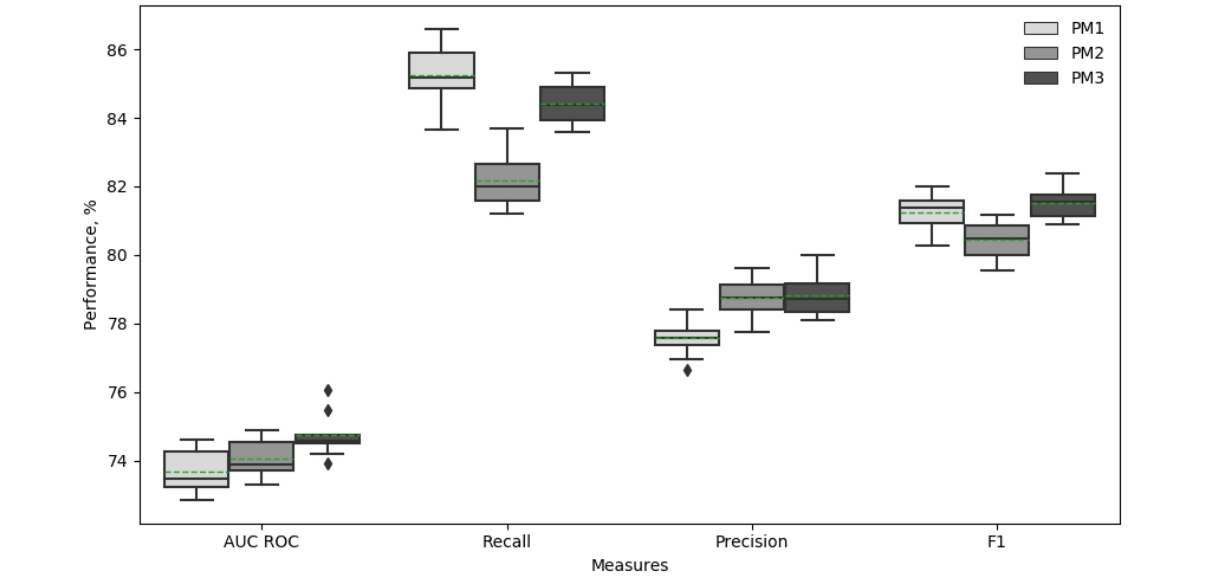
Figure 6. Box plots of the reported measures for the models. AUC ROC: area under the receiver operating characteristic. PM: predictive